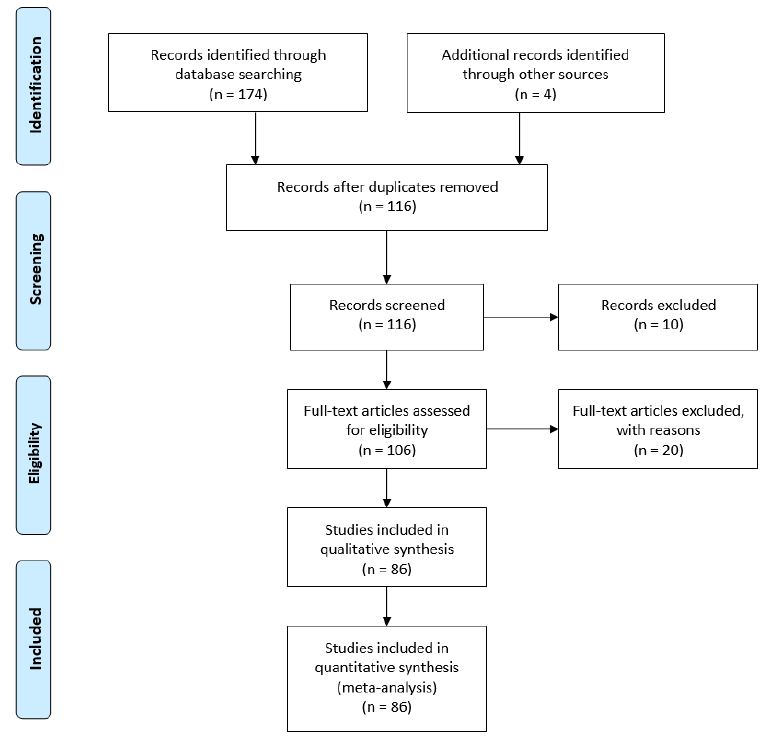
Figure 1. Flow-through diagram for literature search and inclusion/exclusion criteria.